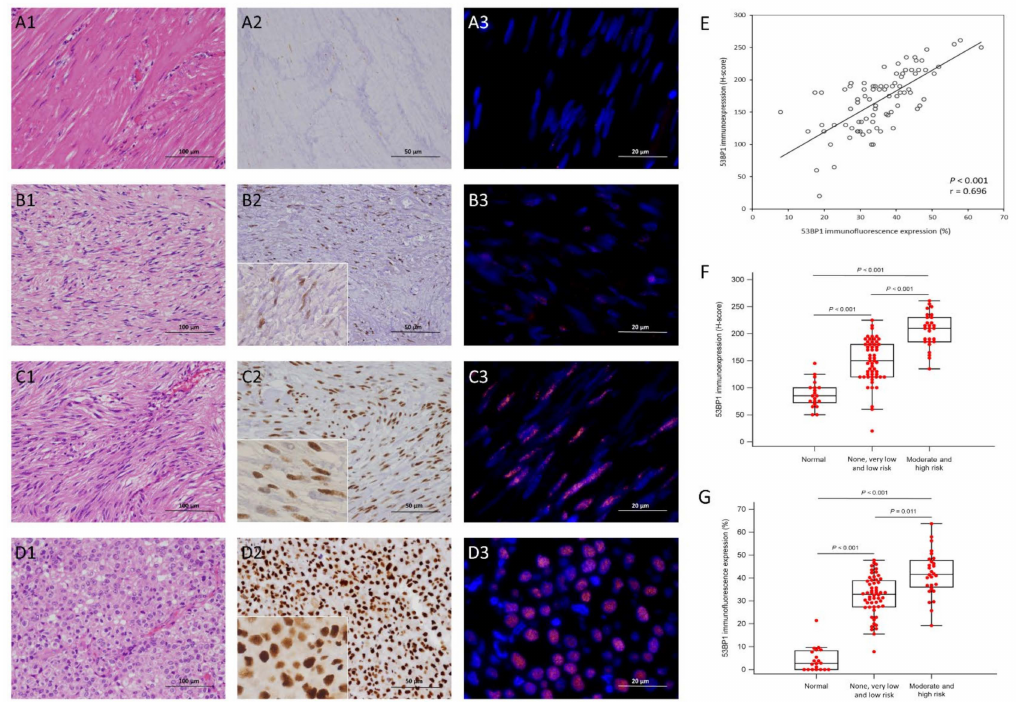
Figure 3. Immunohistochemical and immunofluorescence expression of 53BP1 in GISTs across various risk categories. Compared with the adjacent normal tissue ( A1 ) without very limited and weak nuclear reactivity ( A2 ), representative GISTs showed gradually increasing cellularity and greater epithelioid cytomorphology from the low-risk ( B1 ) to the moderate-risk ( C1 ) and high-risk ( D1 ) cases, via histology ( × 200), and also exhibited focal ( B2 ), moderate ( C2 ) and diffuse strong ( D2 ) nuclear 53BP1 expression, via immunohistochemistry (IHC), in a granular pattern (insets of B2 – D2 , × 400). Compared with the scarce and trivial dot-like signals indicative of very low endogenous expressions in adjacent normal tissue ( A3 ), the immunofluorescence (IF) analysis of 53BP1, similar to IHC, revealed gradually increasing percentages of positively labeled nuclei from the low-risk ( B3 ) to the moderate-risk ( C3 ) and high-risk ( D3 ) GISTs, respectively. ( E ) The scatter plot reliably exhibits a strong correlation between the H-score of 53BP1 immunoexpression on the Y -axis and immunofluorescence expression on the X -axis ( p < 0.001, r = 0.696). The bar charts show similarly and overtly elevated expressions of nuclear 53BP1 in the H-score via IHC (( F ), p < 0.001), and in the percentages of positive cells using IF (( G ), p < 0.001), resulting from the increased levels of the 84 GISTs, wherein the differences were all strongly significant between normal tissue and none/very low-/low-risk cases, and between the latter merged group and the joint group of moderate/high-risk GISTs ( p < 0.001 in all subgroup comparisons via IHC and